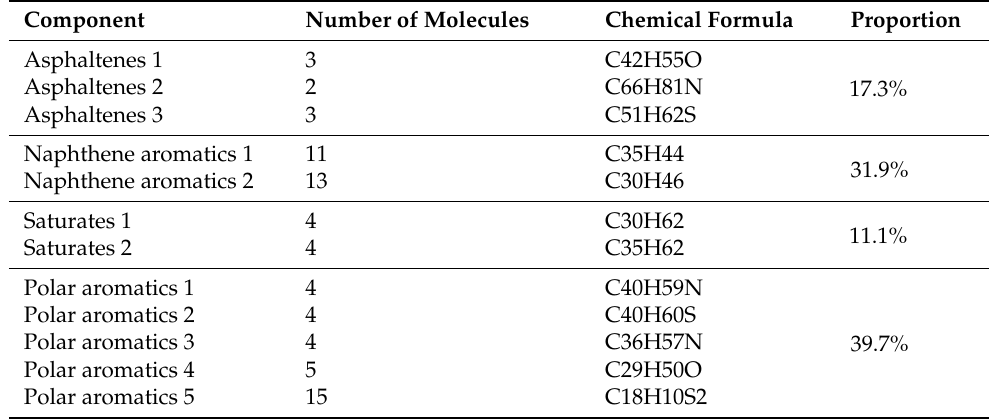
Figure 1. Molecular structure model of the virgin asphalt (carbon atoms are grey; hydrogen atoms are white; oxygen atoms are red; sulphur atoms are yellow; and the blue one is nitrogen). Table 1. Compositions of the asphalt